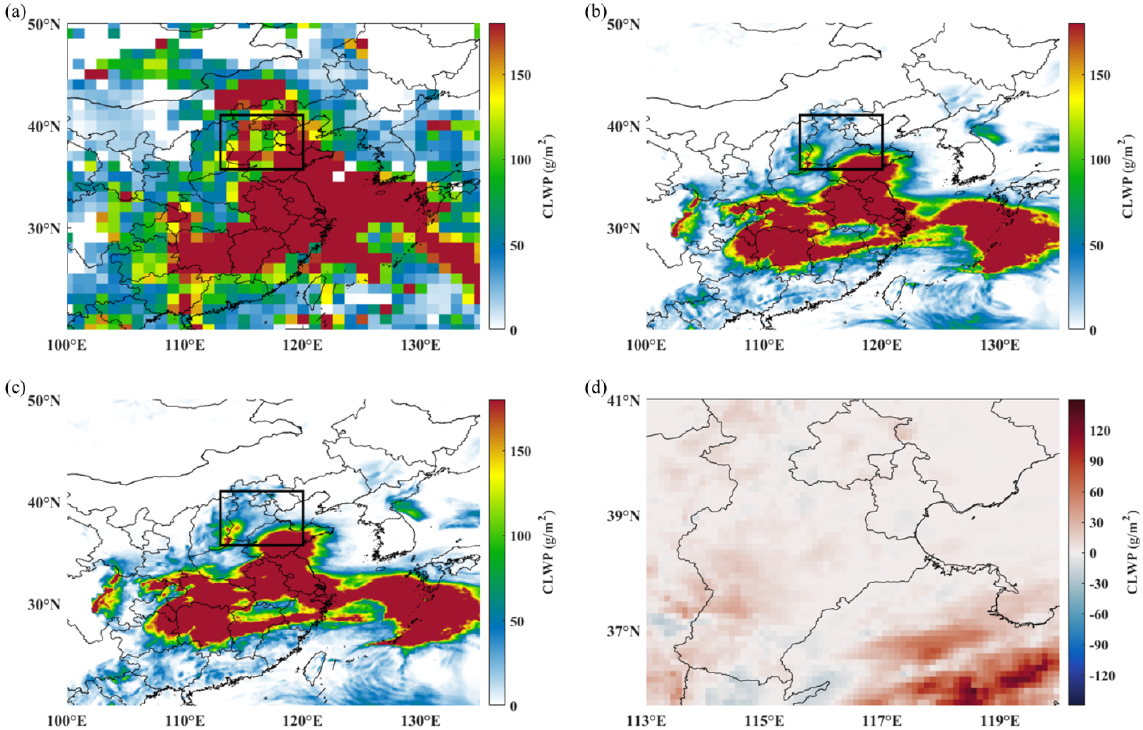
Figure 5. The spatial distribution of mean CLWP on 7 January 2017. (a) VIIRS. (b) The E1 experiment. (c) The E2 experiment. (d) The difference between the E2 and E1 experiment in